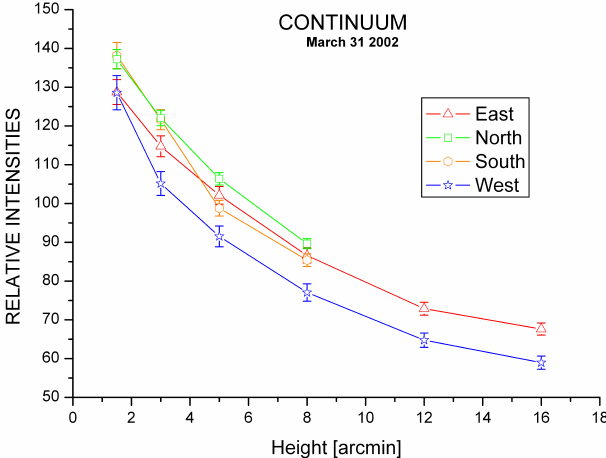
Figure 4 Fig. 4. Radial variations of the average intensities of the aureola background measured in the neighbouring continuum of the coronal line at 530.3nm. Time of the day when the data are collected are shown in Table 1. Accordingly, the Earth’s atmospheric component of the aureola changes by a small amount. Intensities are given in units of 10 − 6 of the average brightness of the solar